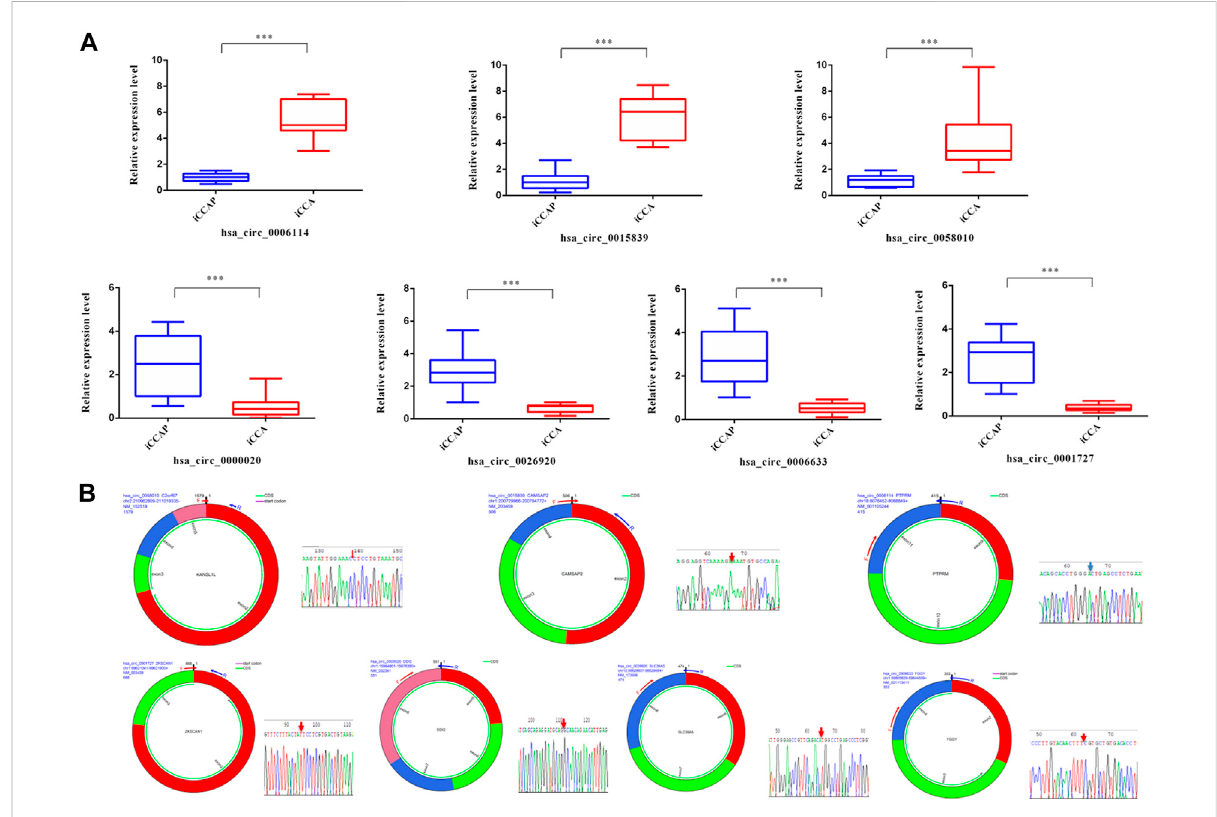
FIGURE 3 Validation of circRNAs with real-time PCR and sequencing. (A) The expression levels of circRNAs (hsa_circ_0006114, hsa_circ_0015839, hsa_circ_0058010, hsa_circ_0000020, hsa_circ_0001727, hsa_circ_0006633, and hsa_circ_0026920) were detected using real-time PCR. (B) Sanger sequencing of seven PCR products resulting from divergent primers demonstrating the head-to-tail